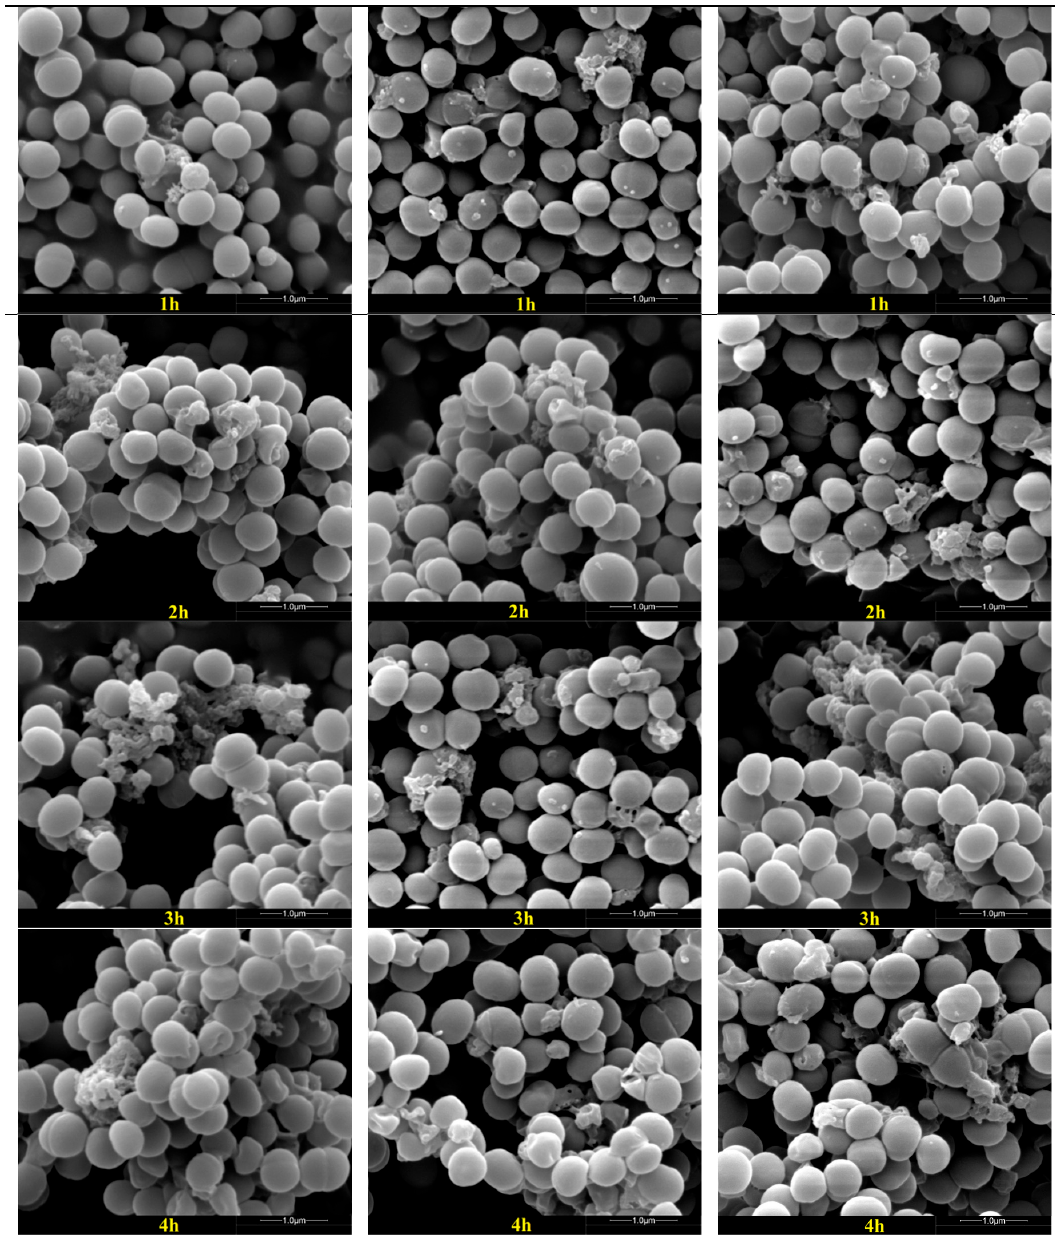
Figure 3. Effects of L, C, and C-L on S. aureus ATCC 25293 morphology and integrity. The first, second,